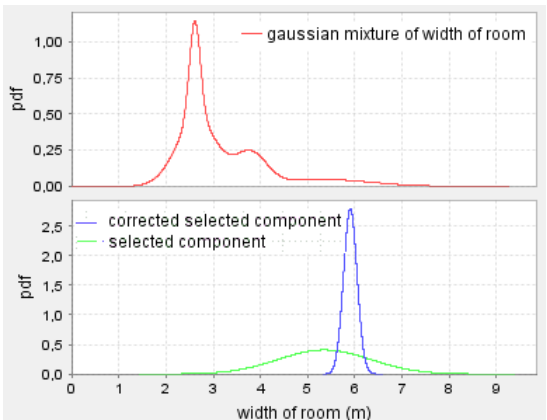
Figure 2: Probability density functions (pdfs) for the width of office rooms: Gaussian mixture as prior (top), from CLP se- lected component for determining the posterior of a given floor- plan (bottom, green) and by Kalman filter corrected selected com- ponent (bottom,